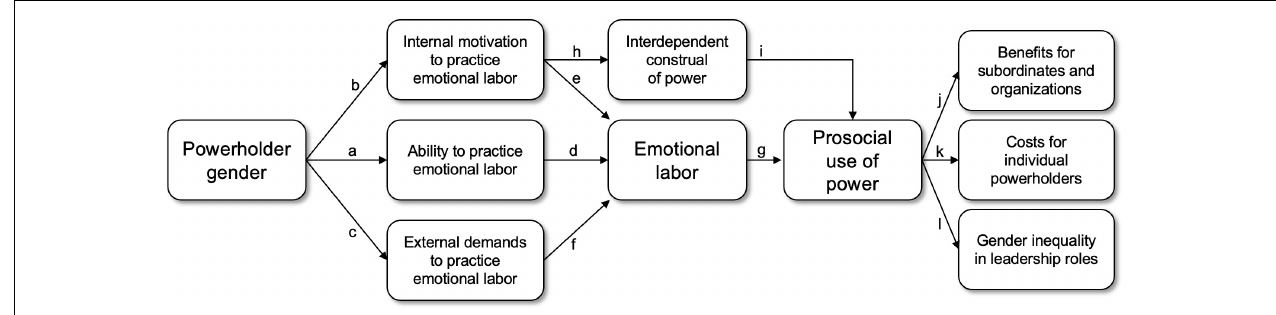
FIGURE 1 | Theoretical model connecting gendered patterns of emotional labor with the prosocial use of power and its downstream consequences. Powerholder gender is related to differences in the ability ( path a ) and the internal motivation ( path b ) to practice emotional labor, as well as in external emotional labor demands ( path c ). These three factors directly contribute to emotional labor ( paths d–f ), which underlies the prosocial use of power ( path g ). Additionally, a stronger internal motivation to practice emotional labor is associated with a more interdependent construal of power ( path h ), which influences the tendency to enact power in prosocial ways ( path i ). The prosocial use of power has benefits for subordinates and organizations ( path j ), but it can also create costs for individual powerholders ( path k ) and undermine gender equality in leadership roles ( path l ).